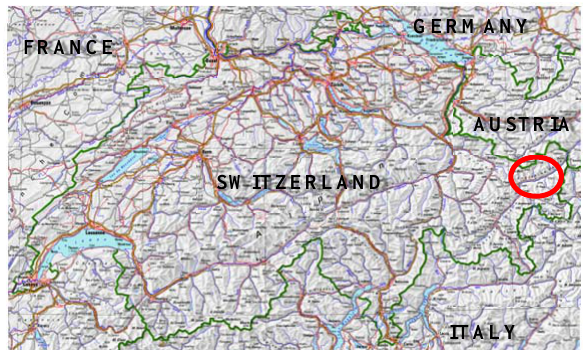
Figure 1: Location of the Archaeological Site, Plan da Mattun